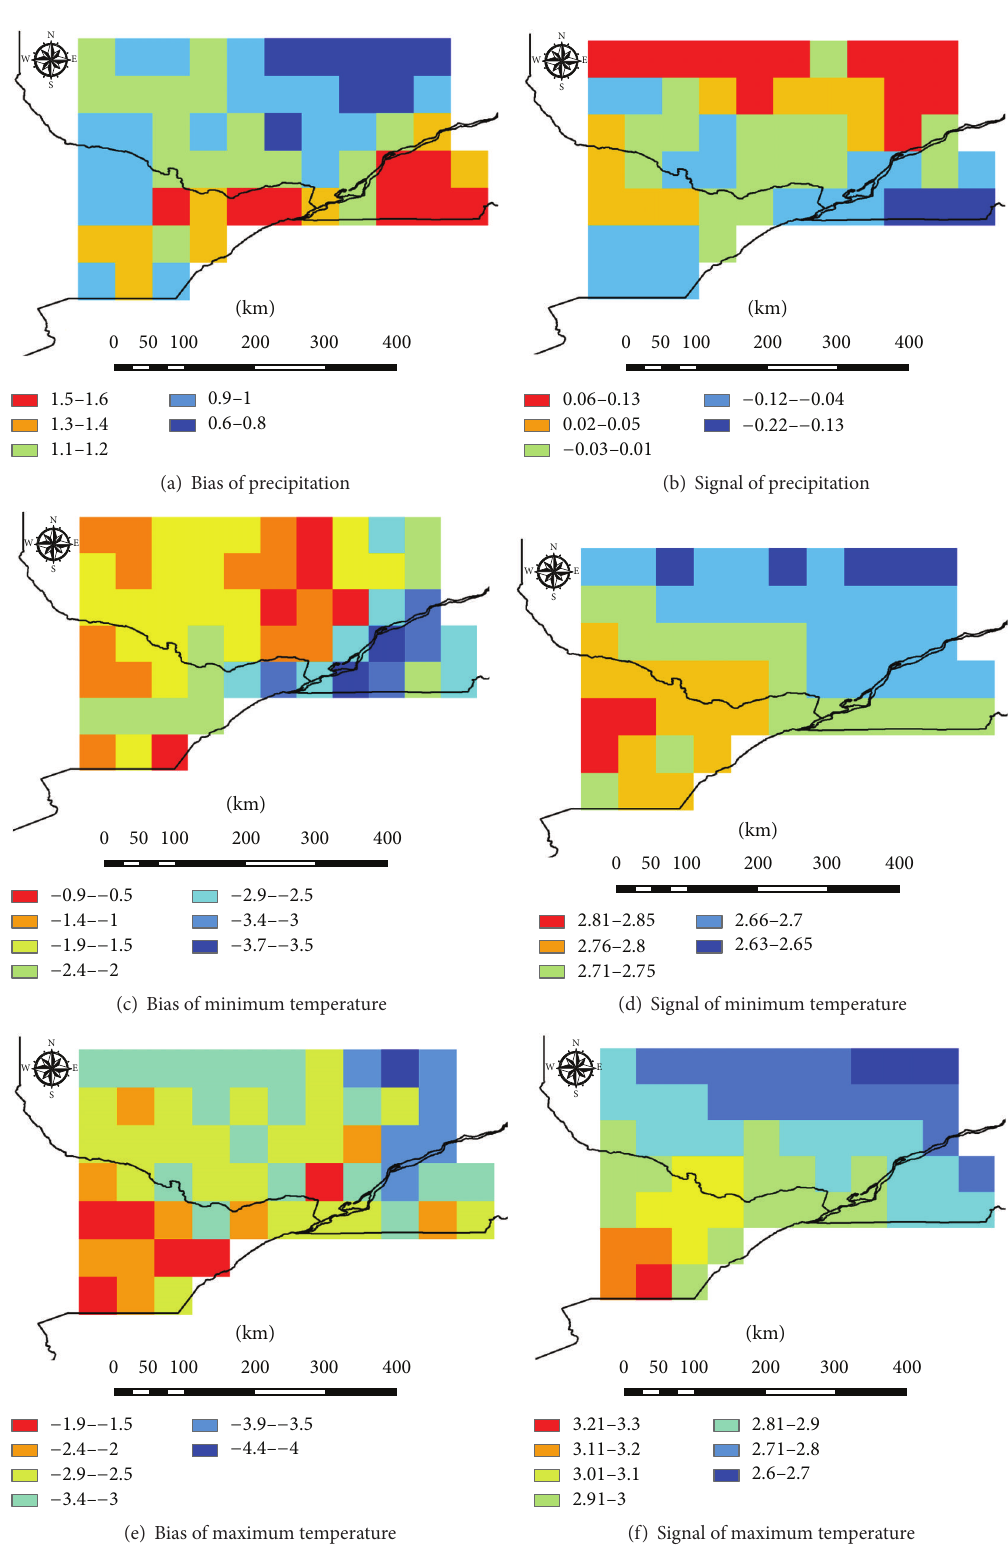
Figure 2: Spatial map of intermodel biases and climate change signals averaged for all RCM/AOGCMs’ simulations during summer season for precipitation (in mm/d) and minimum and maximum temperatures (in ∘